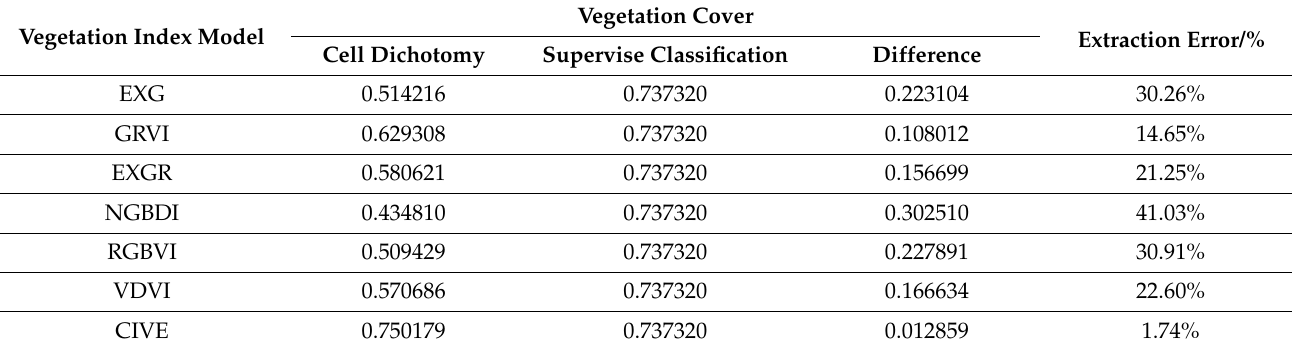
Table 4. Accuracy evaluation of different vegetation coverage models.